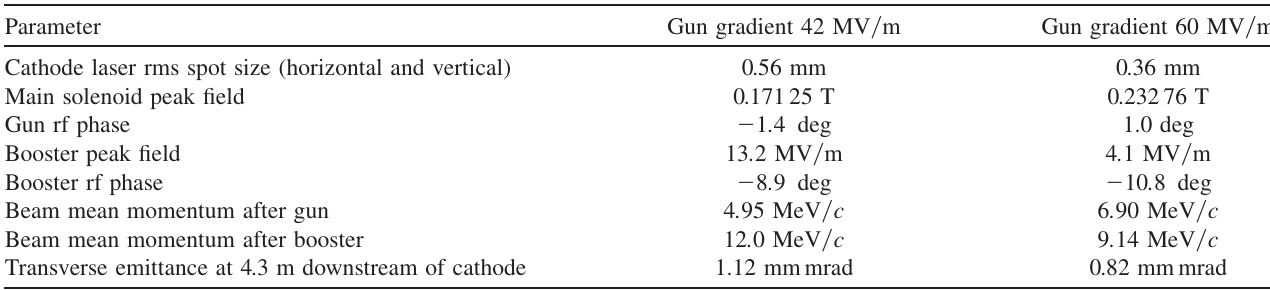
TABLE V. Optimized photoinjector parameters according to ASTRA